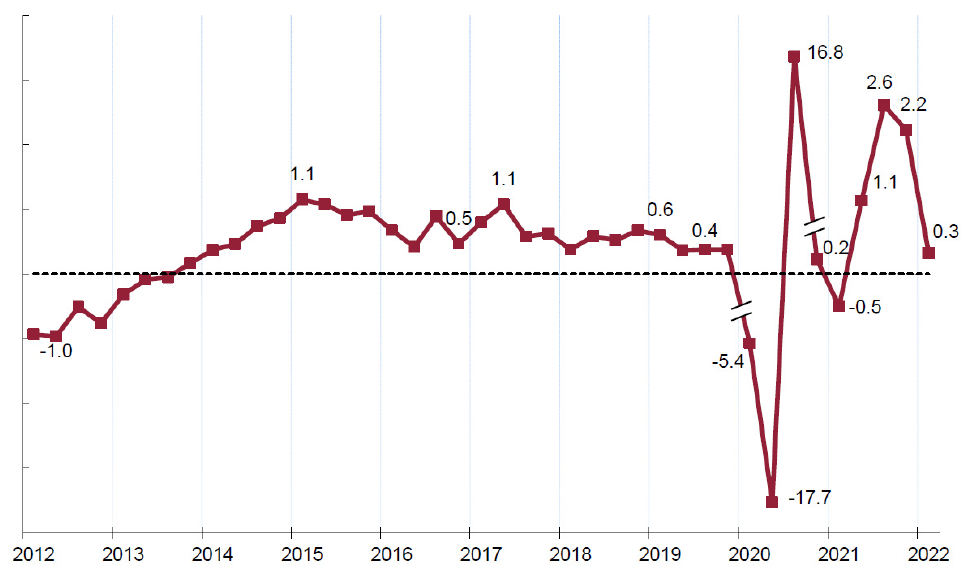
Graph 1. GDP Spain. Chain-linked volume. Quarter-on quarter variation rates (%). Source: INE (2022, p.